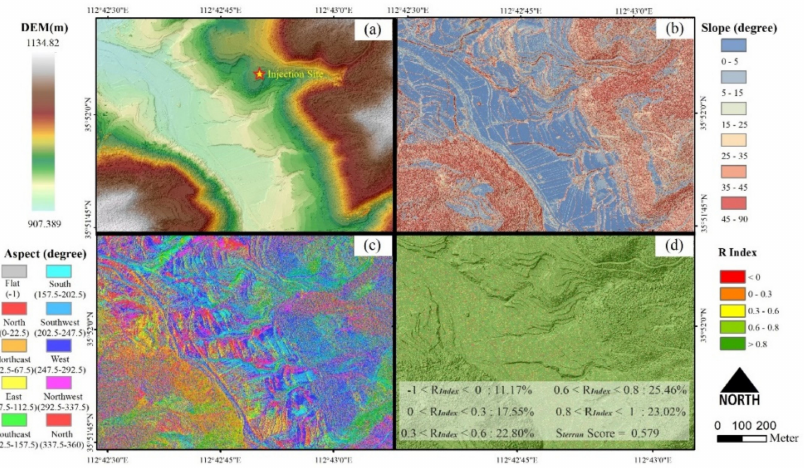
Figure 3. The graphs show the topographic parameters of Shizhuang, Shaanxi Province, China. ( a ) shows the DEM extracted using a UAV. ( b ) and ( c ) show the slope and aspect parameters extracted from the DEM. ( d ) illustrates the R Index of the injection area and the S terrain score calculated from the